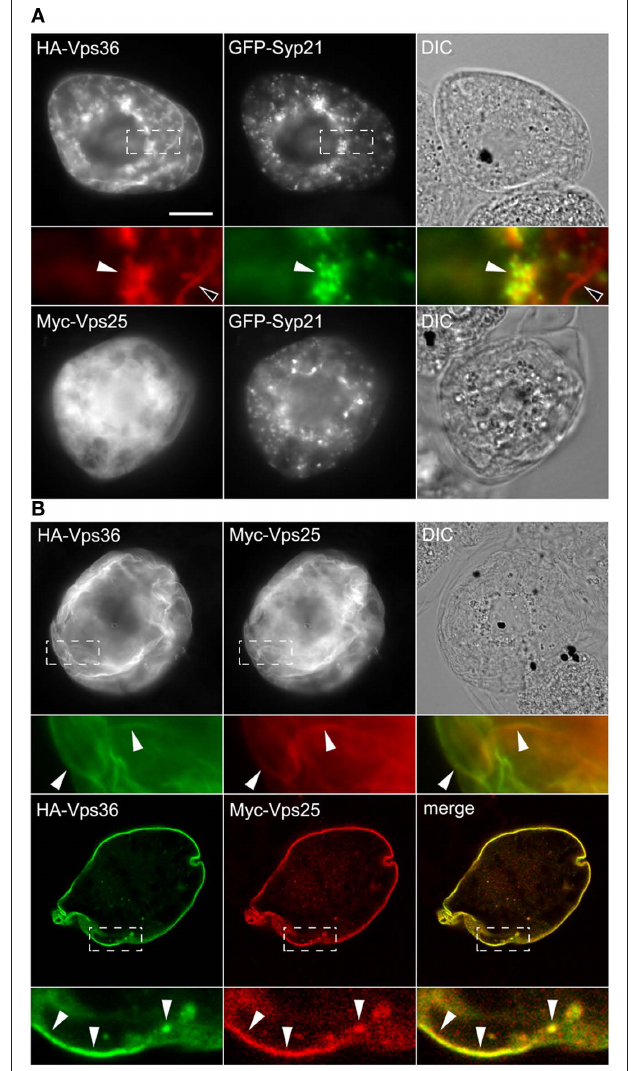
FIGuRE 5 | Subcellular localization of Vps25 and Vps36. BY‑2 cells were co‑transformed with the indicated gene constructs and then cells were processed, imaged, and analyzed either by epifluorescence microscopy [ (A,B) top row] or [ (B) bottom row] CLSM as described in the legend of Figure 2 . The yellow color in the corresponding merged images indicates co‑localization between co‑expressed proteins; white arrowheads also indicate obvious protein co‑localization, while open arrowheads in (A) indicate the localization of HA‑Vps36 (but not co‑expressed GFP‑Syp21) at the plasma membrane. Bar =